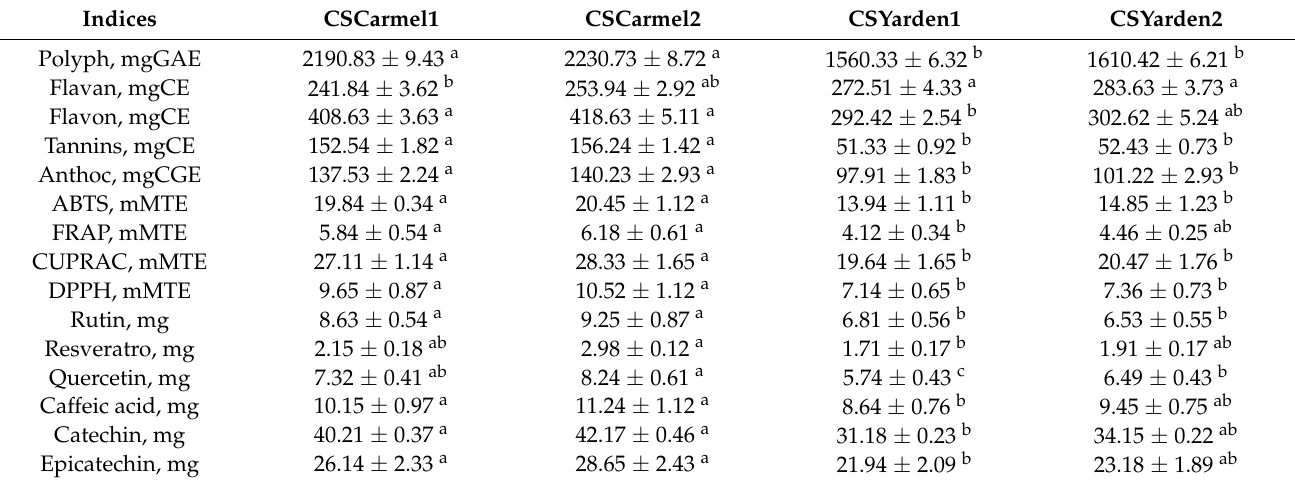
Table 1. Bioactive substances and antioxidant activities of red wines x